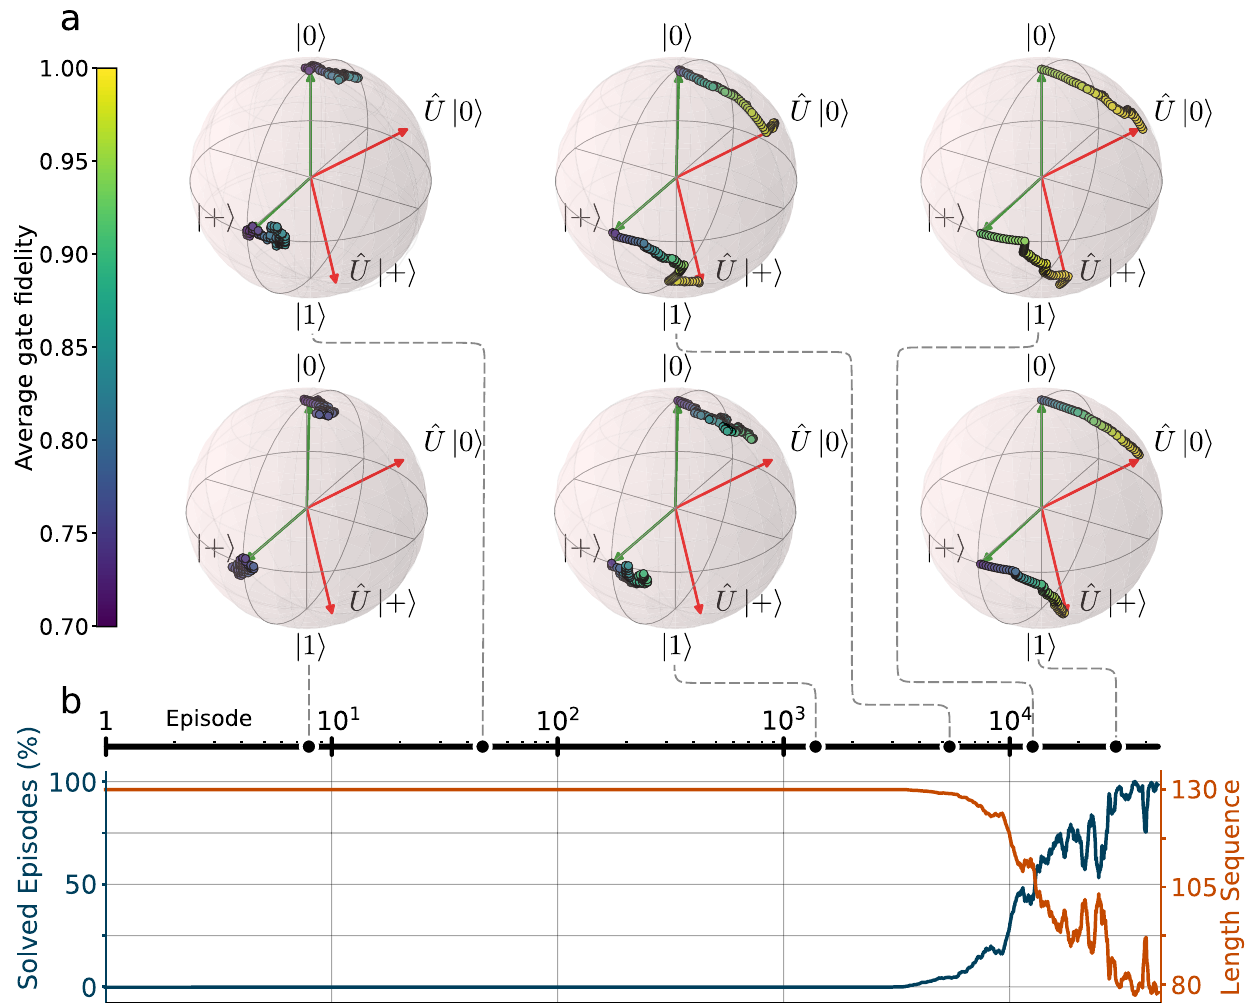
Fig. 2 The deep reinforcement learning agent learns how to approximate a single-qubit gate. a Best sequences of gates discovered by the agent during the training at different epochs. The dashed lines connecting the Bloch spheres to the Episode axis indicate the episode at which the sequences were found for the fi rst time. Each approximating sequence is represented by two trajectories of states (colored points) on the Bloch sphere. They are obtained by applying the unitary transformations associated with the circuit at the time step n on two representative states, namely 0 j i and þj i respectively. The agent is asked to transform the starting state (green arrows) in the corresponding ending state (red arrows), i.e., 0 j i to U 0 j i and þj i to U þj i respectively, where U corresponds to the unitary target. b Performance of the agent during training. The plot represents the percentage of episodes for which the agent was able to fi nd a solution (blue line) and the average number of the sequence of gates (orange line). The agent learns how to approximate the target after about 104 episodes and then improves the solution over